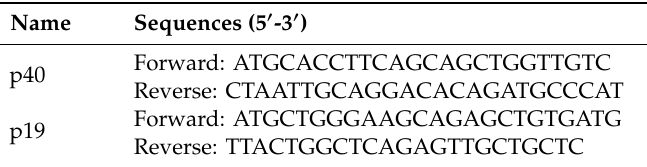
Table 1. Primers sequences of p40 and